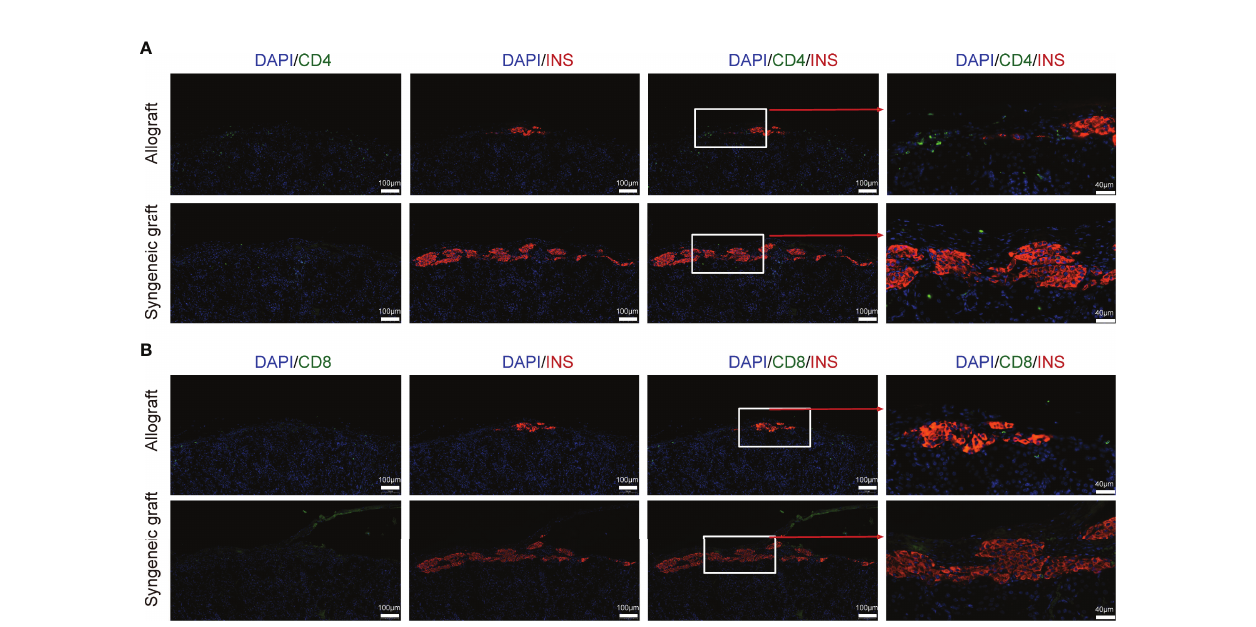
FIGURE 3 | Localization of T cells in islet allograft. (A) Representative image of a graft section stained with antibodies speci fi c for Insulin (red), CD4 (green), and DAPI nuclear counterstain (blue). (B) Representative image of a graft section stained with antibodies speci fi c for Insulin (red), CD8 (green), and DAPI nuclear counterstain (blue). Syngeneic islets graft (C57BL/6 islets to C57BL/6 recipients) and allogeneic islets graft (BALB/c islets to C57BL/6 recipients) were harvested 7 days post-transplantation and sectioned together with mouse